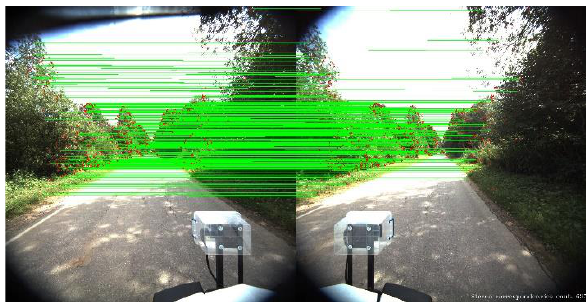
Figure 7. Stereo correspondences of some